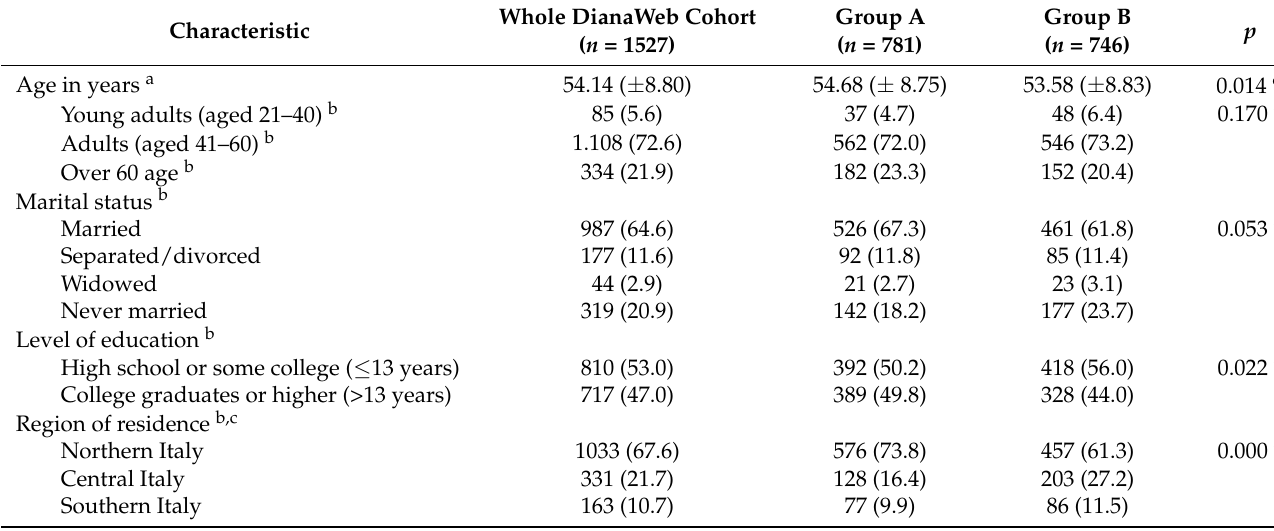
Table 1. Main sociodemographic characteristics of the DianaWeb cohort, and surveillance study participants. Characteristic